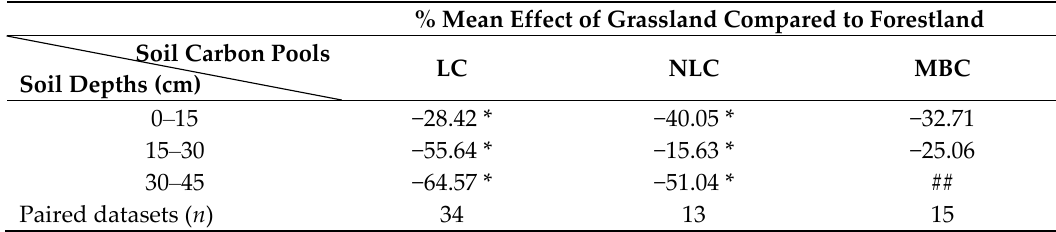
Table 5. Mean effect of grassland compared to forestland on soil carbon pools at various depths in India.